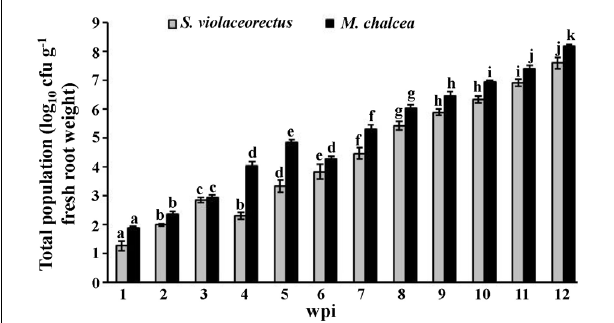
FIGURE 2 | Total population of Micromonospora chalcea UAE1 and Streptomyces violaceorectus UAE1 in Salicornia bigelovii roots. The tested endophytic actinobacterial populations in the roots of S. bigelovii grown under greenhouse conditions were sampled at different time points. Values are means of eight replicates ± SE for each sampling from two independent experiments. Mean values followed by different letters are significantly ( P < 0.05) different from each of the total populations of each strain according to Fisher’s Protected LSD Test. wpi, weeks post